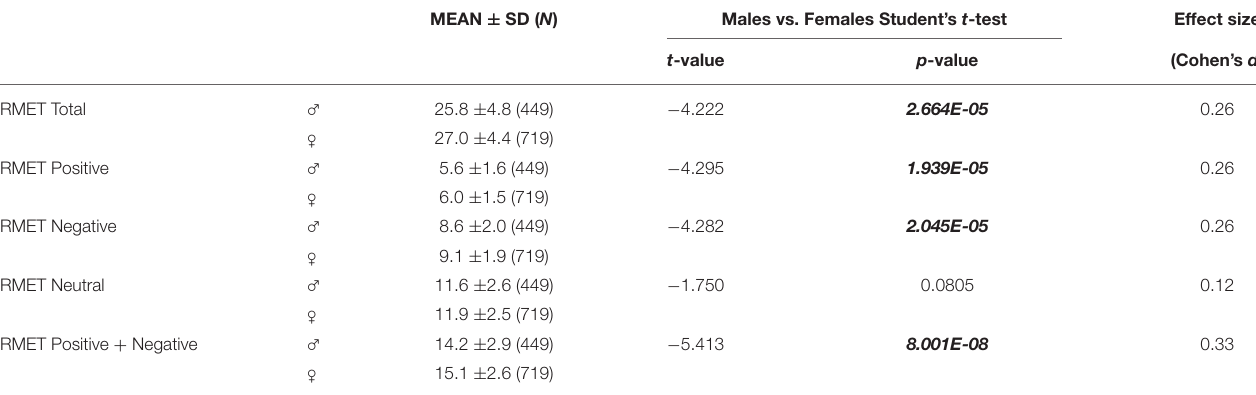
TABLE 1 | Sex differences in RMET Total scores by valence of